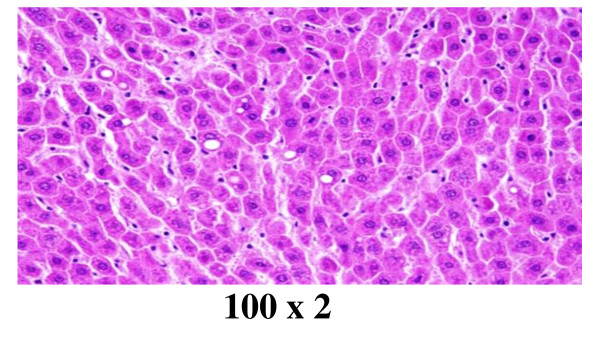
GNPs-treated rat received 100 μl of 50 nm particles for 7 days